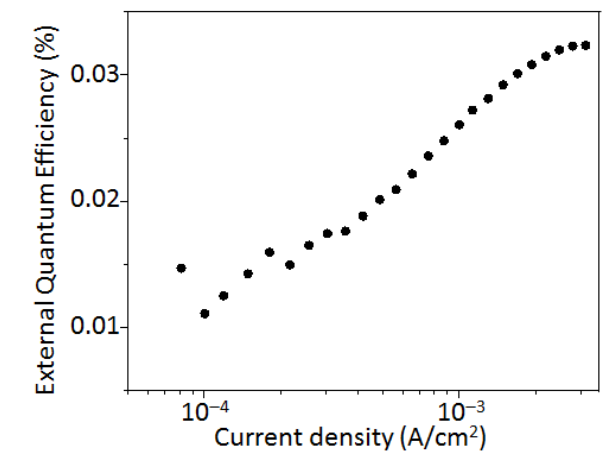
Figure 5. External quantum efficiency (EQE) versus device current density.